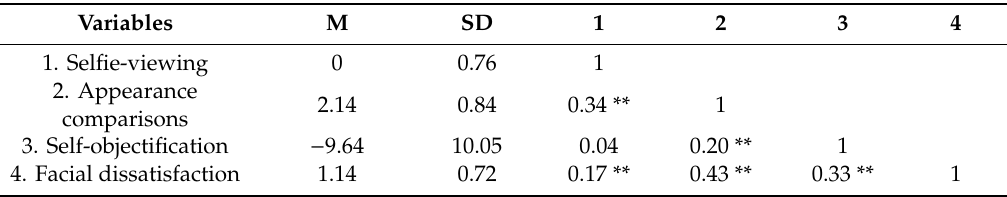
Table 1. Means, standard deviations, and zero-order correlations for main study